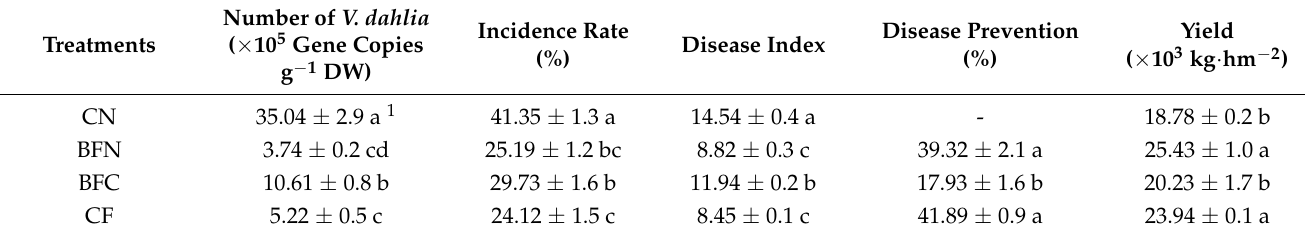
Table 1. Effects of treatments on the abundance of Verticillium dahlia and yield improvement.